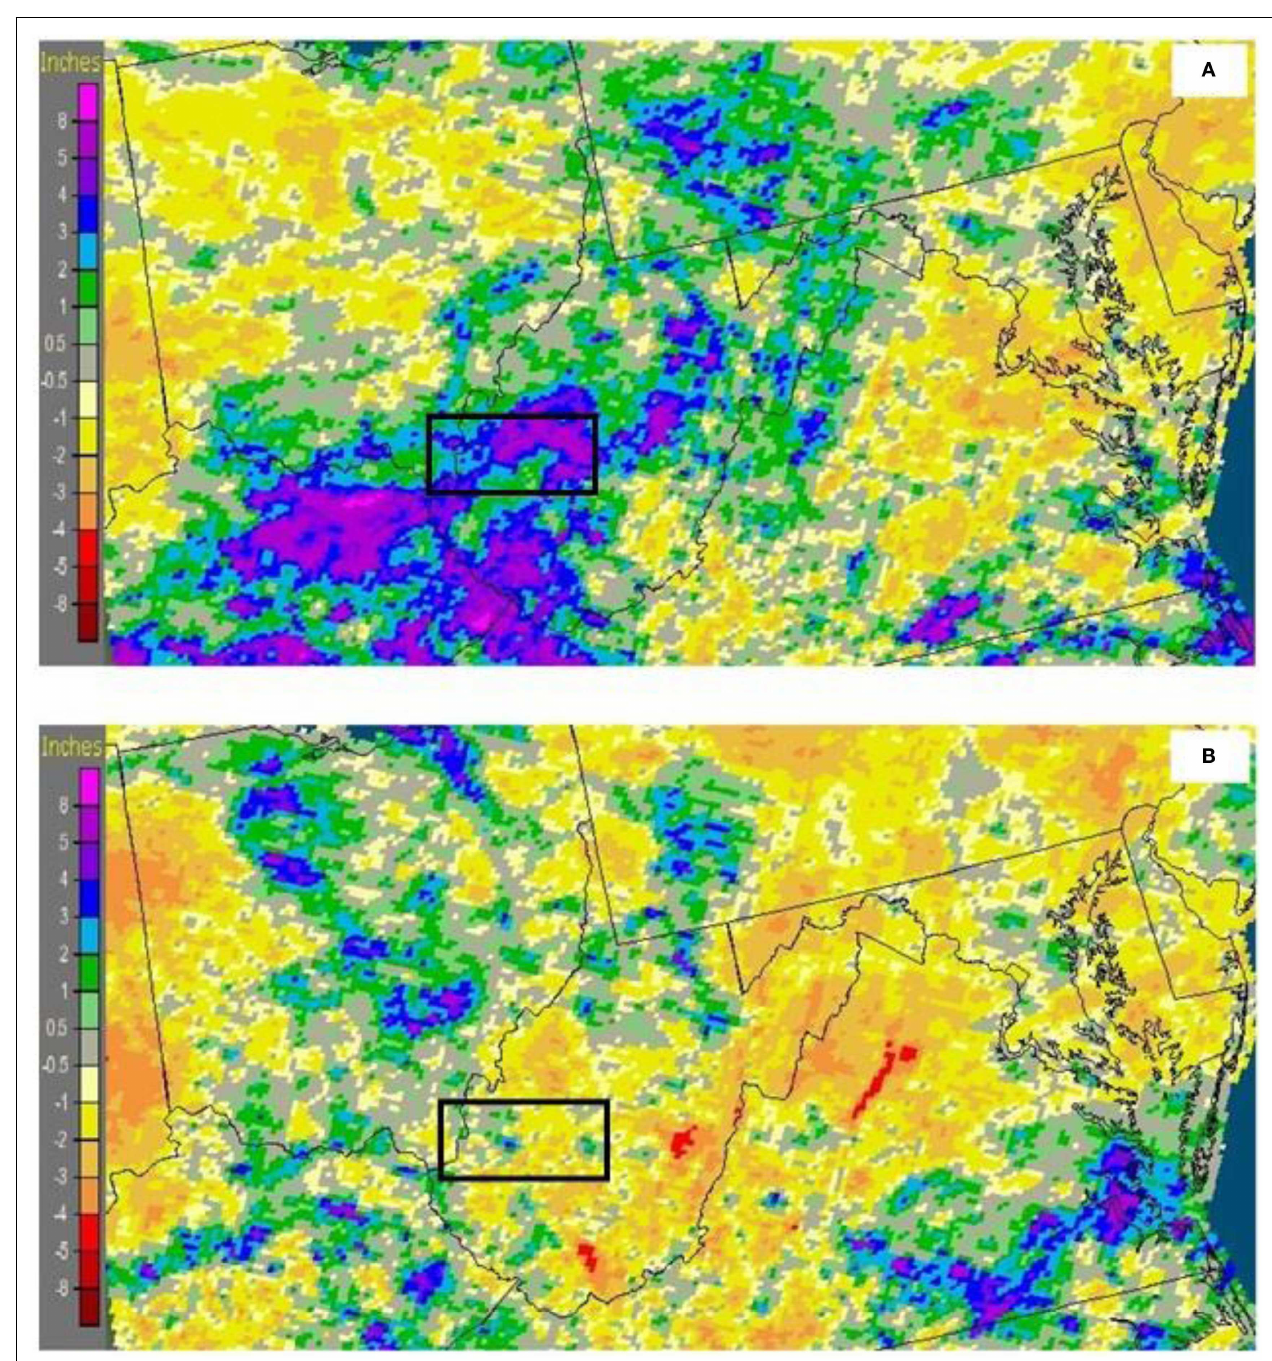
FIGURE 5 | Departure of precipitation from historical averages during (A) July 2012 and (B) July 2011 . Data and images were obtained from NOAA-National Weather Service. (Black box in the figure – 38.6825°N to 37.8788°N; 82.5844°W to 81.0955°; and include Cabell and Kanawha counties ofWestVirginia).